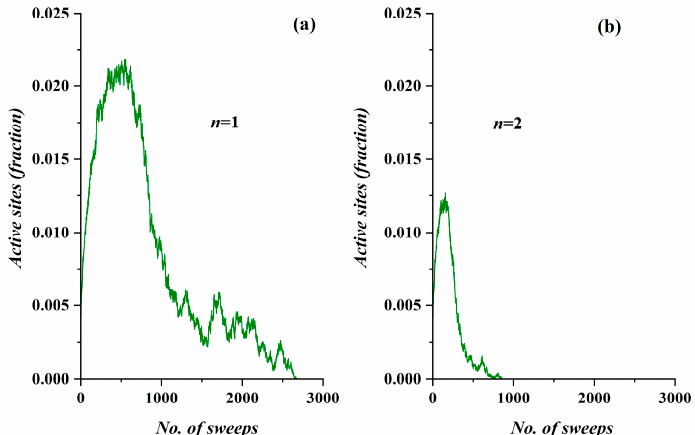
Figure 1. ( a ) The temporal evolution of the fraction of the active sites (order parameter) vs. the algorithmic time for the case n = 1, and ( b ) for the case n = 2. In both cases, the runs regarded a lattice with L = 250 sides, with communication capability restricted by 50% (2 out of 4 nearest neighbors may receive charge), and the same initial density of ρ = 0.055.